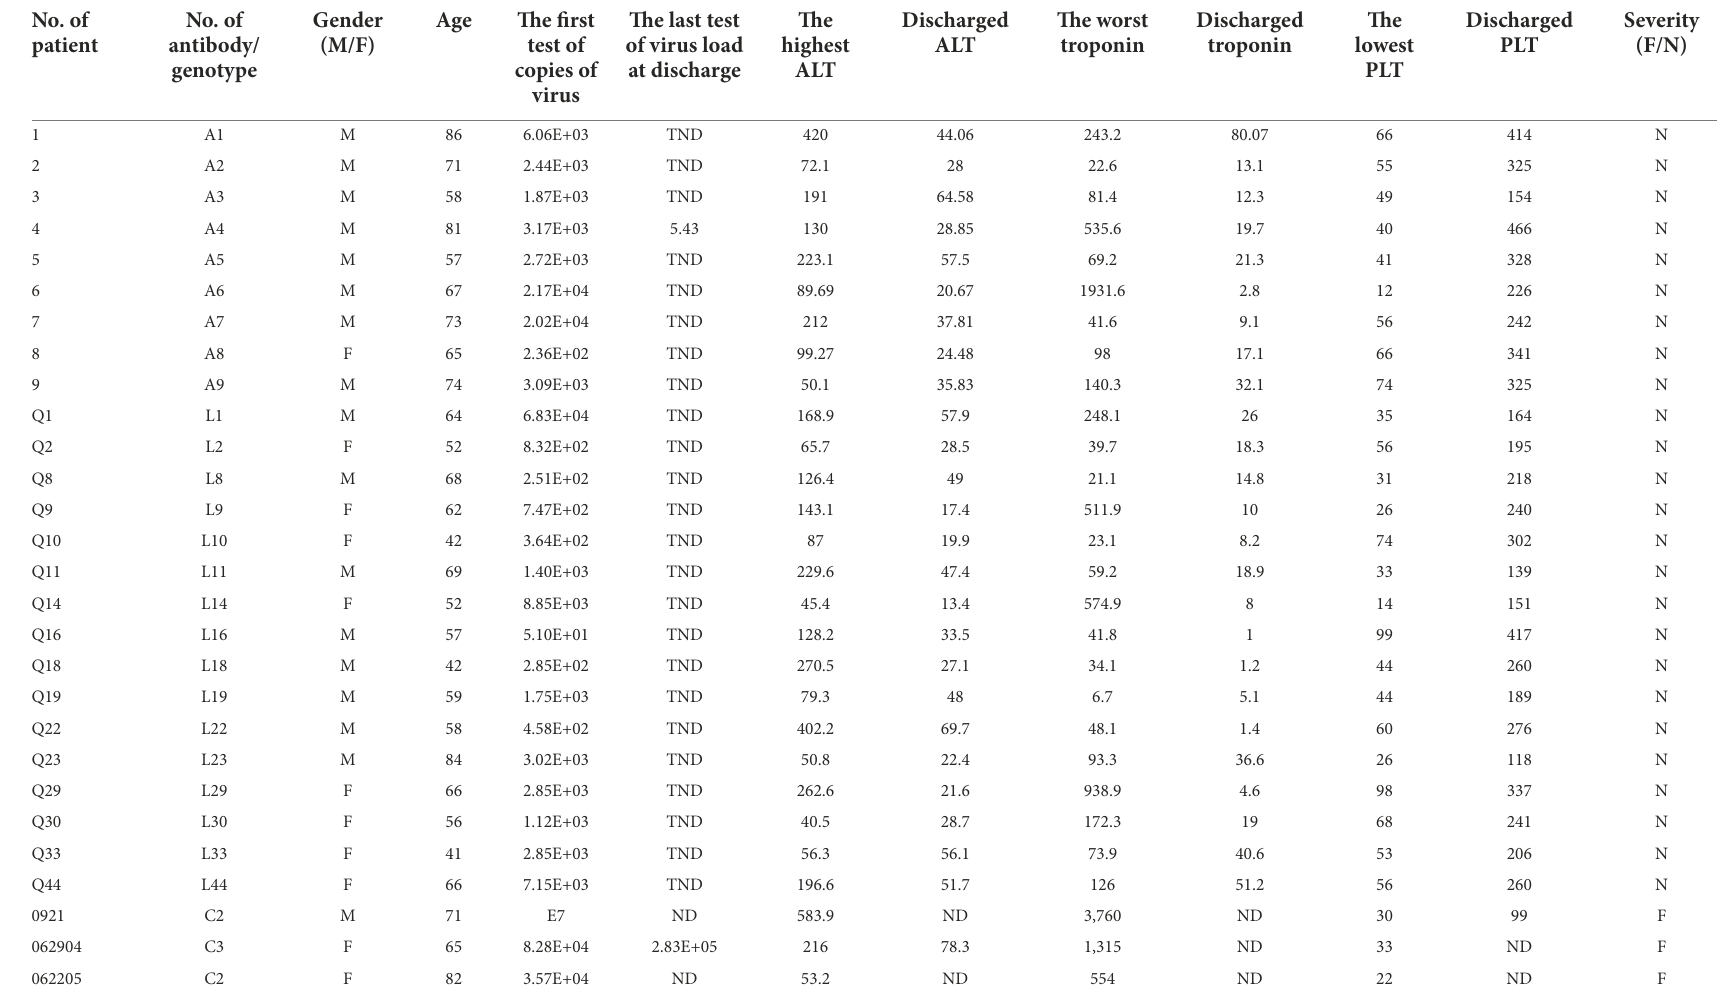
TABLE 1 The characteristics of convalescent of SFTS.